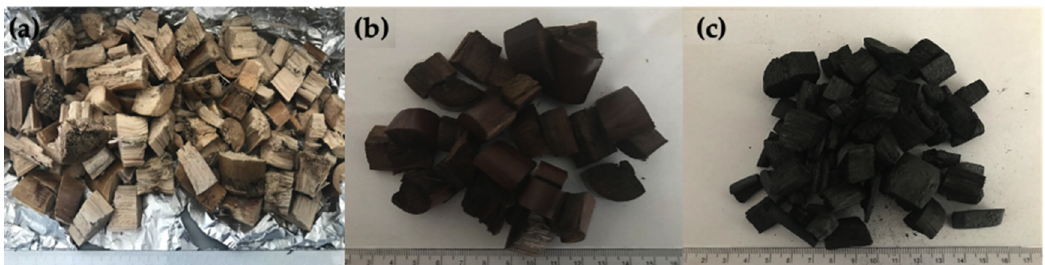
Table 3. Temperature and residence times used in the tests.